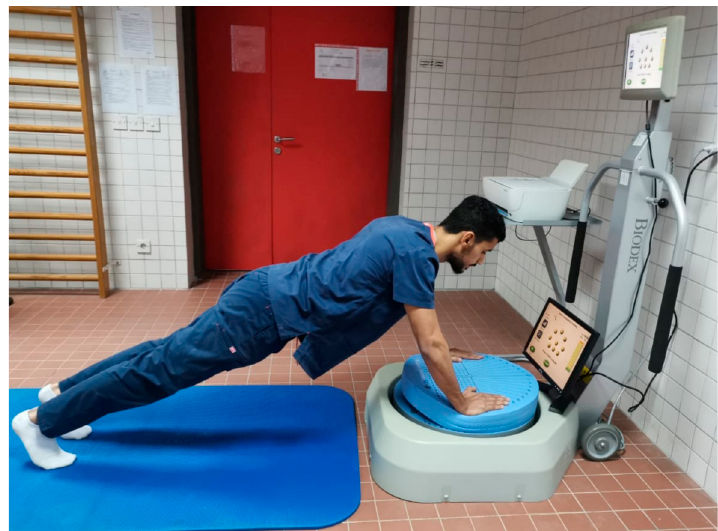
Figure 4. Biodex Balance System (BBS), training procedures.